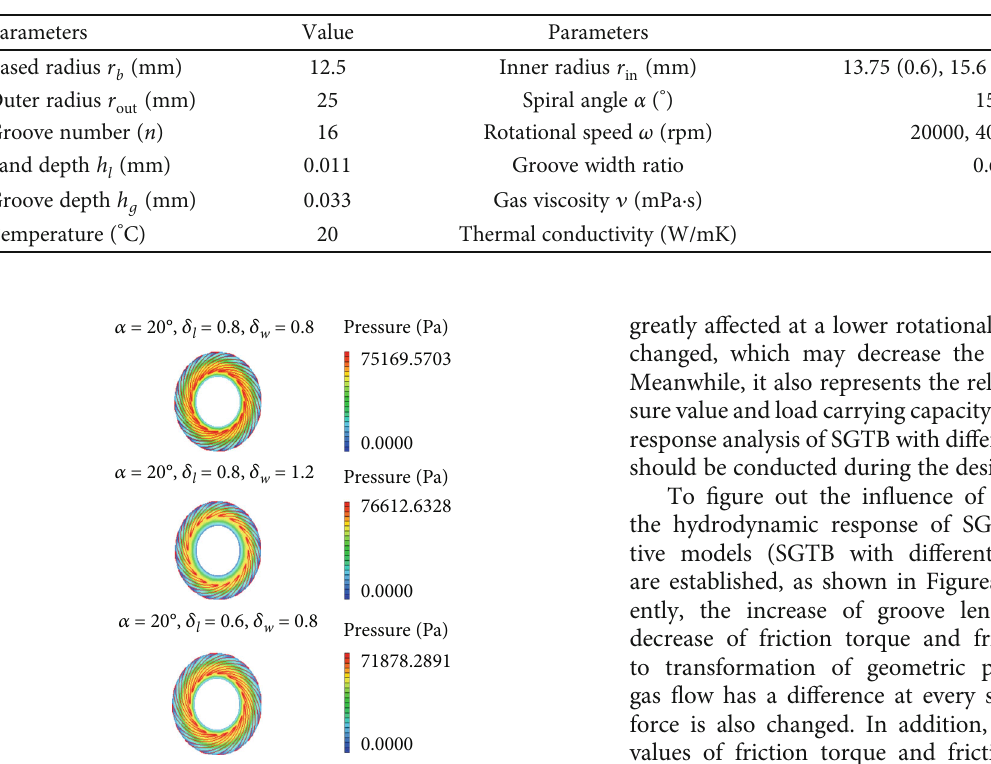
Table 1: Simulation parameters of the spiral-grooved thrust bearing.